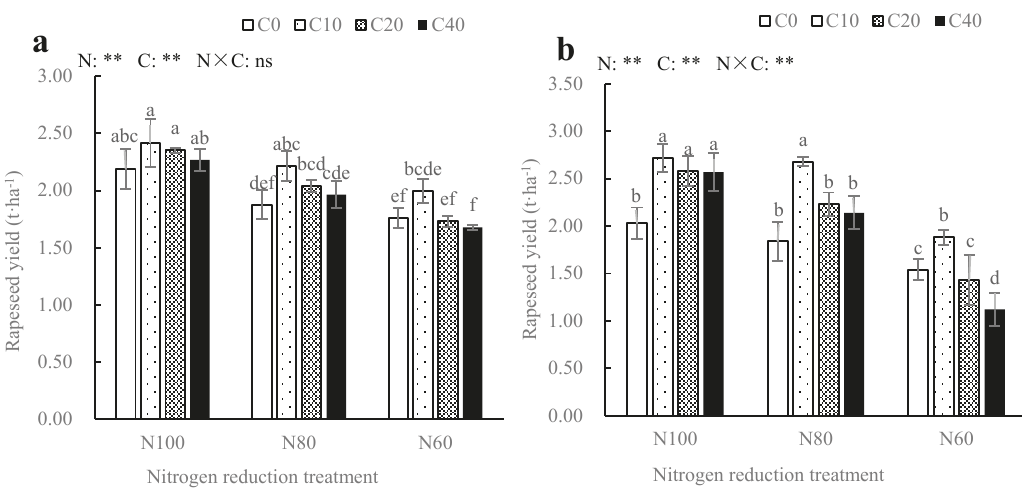
Figure 2. Rapeseed yield of biochar combined with reducing nitrogen application rate in 2018 ( a ) and 2019 ( b ). Different lowercase letters indicate significant differences at the different treatments at LSD 0.05 . N means nitrogen fertilizer; C means biochar; the “ns” means the difference is not significant and the “**” indicate significant difference at p < 0.01.